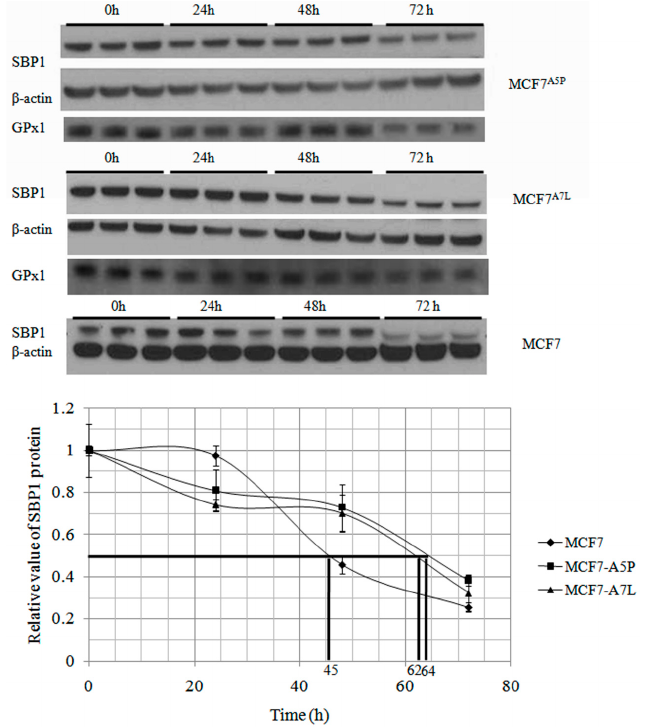
Figure 2. GPx1 extends endogenous SBP1 protein half-life. After treated with 100 µg/mL cycloheximide for 24, 48, and 72 h, different MCF7 derivative cells were harvested and protein levels of SBP1 were determined by immunoblot analysis. The signals were quantified by densitometry using ImageJ Software and normalized to β -actin. The determined half-life of SBP1 was 45, 64, and 62 h in MCF7, MCF7 A5P , and MCF7 A7L cells, respectively. The differences between MCF7 and MCF7 A5P , MCF7 A7L cells are statistically significant ( p < 0.05).